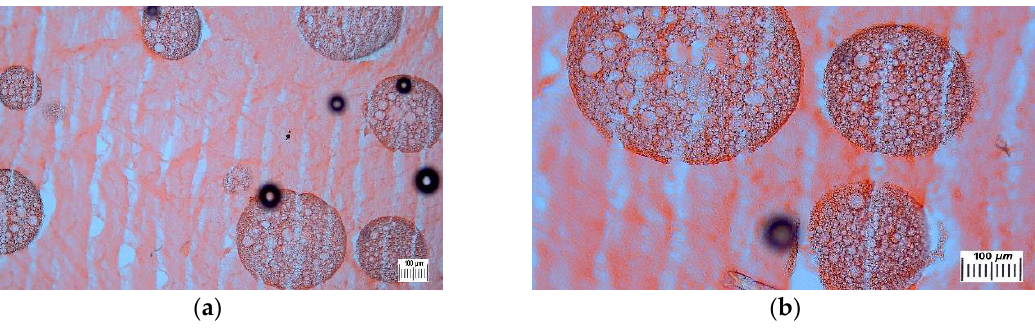
Figure 4. Optical micrographs at a lower (a) and a higher (b) magnifications of the Congo red-stained thin section of the composite PVA cryogel prepared from the initial system of the 2 c composition (Table 1).